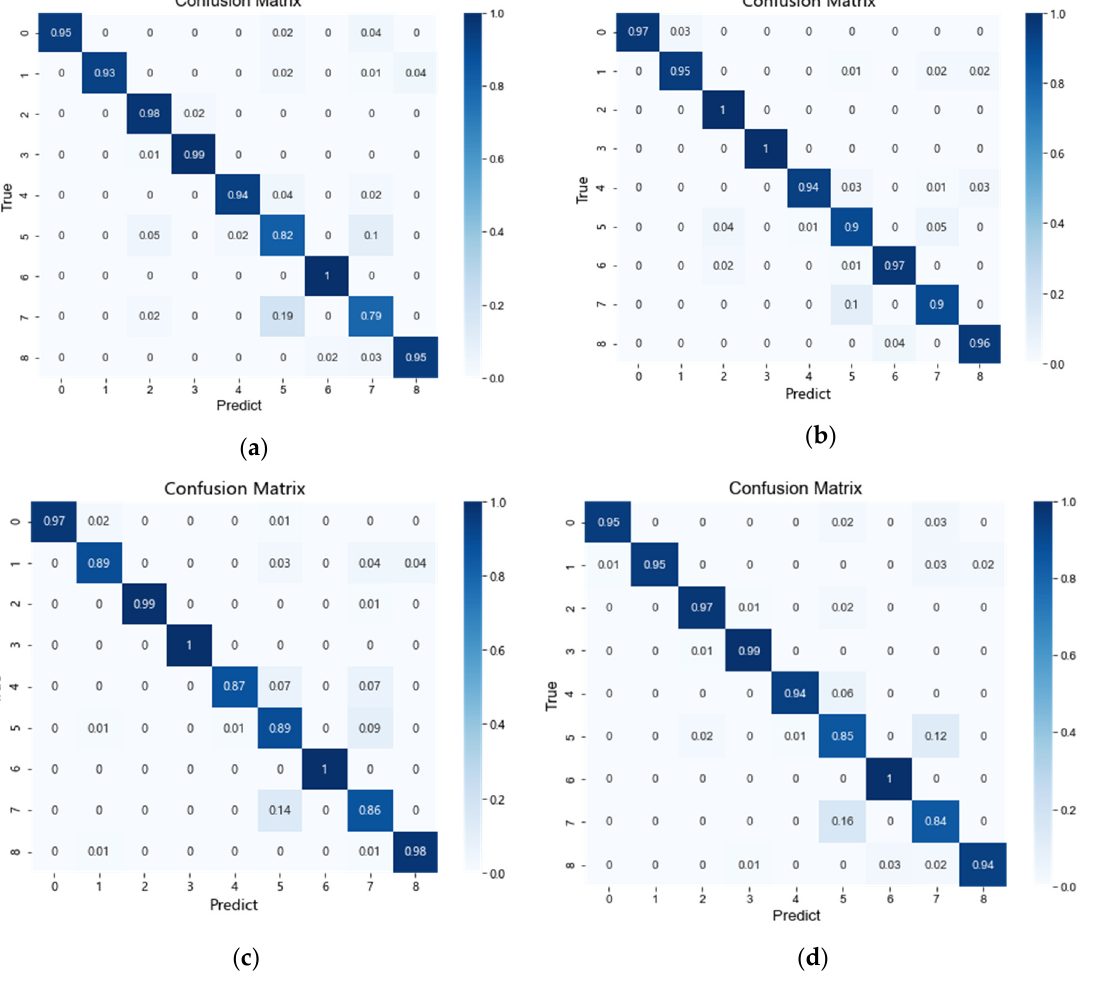
Figure 12. Comparison of confusion matrices under a different rebalanced dataset: ( a ) the confusion of the imbalanced dataset; ( b ) the confusion of the MS-PGAN-generated dataset; ( c ) the confusion of the DCGAN-GP-generated dataset; ( d ) the confusion of the SMOTE-generated dataset.